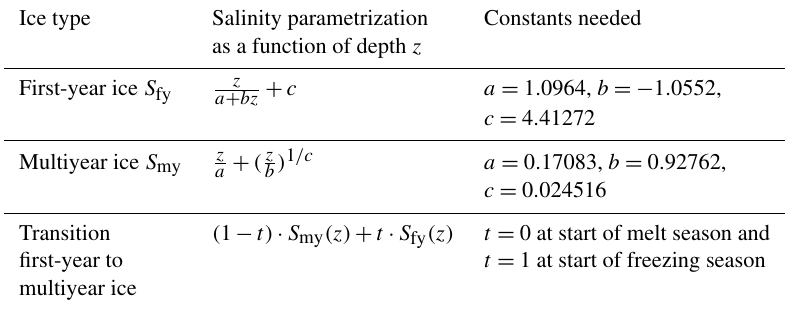
Table B1. Formulas describing salinity as a function of depth, from Griewank and Notz (2015), as shown in the solid lines in Fig.